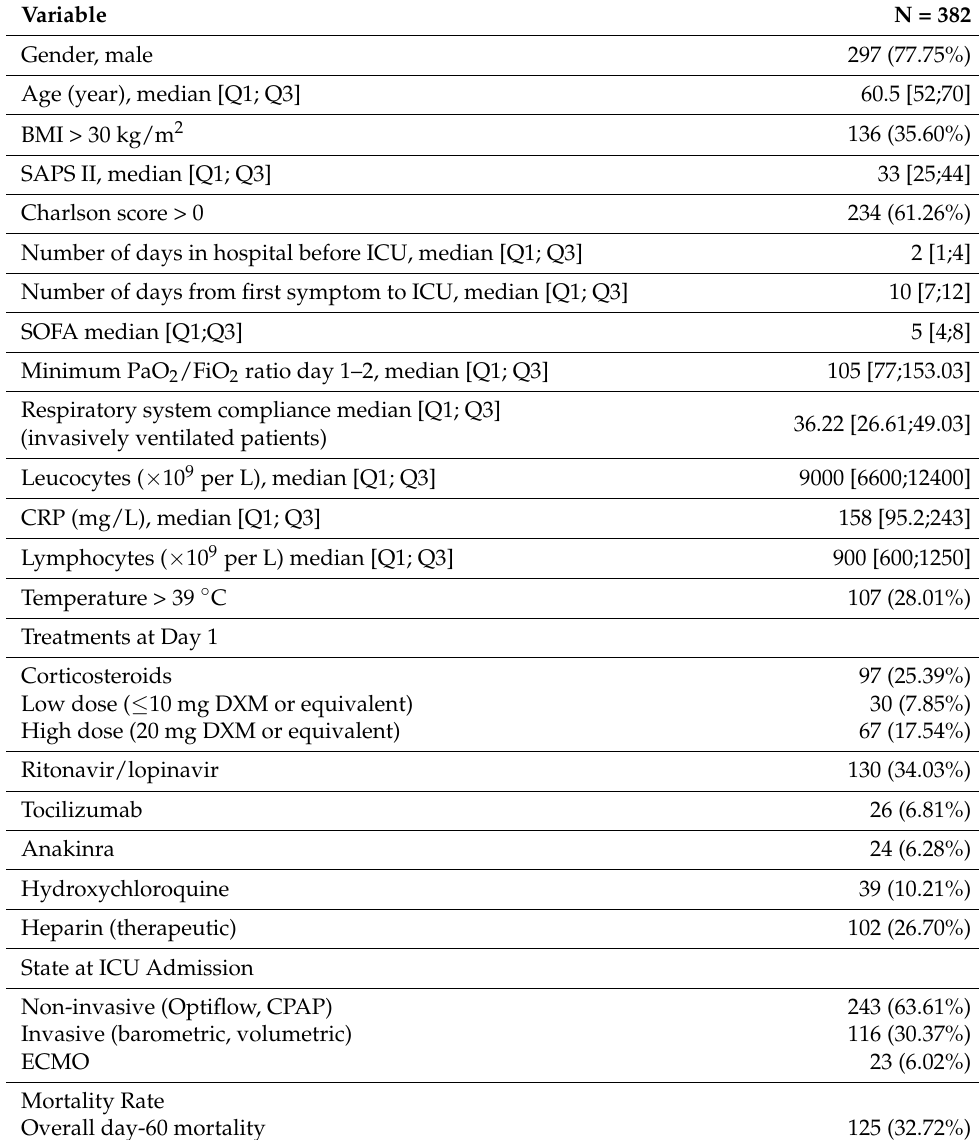
Table 1. Characteristics in the ICU population ( n =